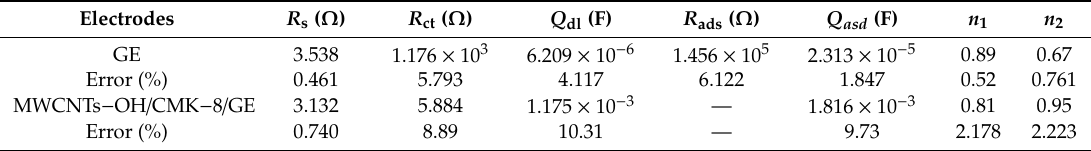
Figure 3. ( A ) Nyquist and ( B ) Bode diagrams of GE and MWCNTs − OH/CMK − 8 modified electrode in 1.0 μ mol/L OLA. T he inset is the Equivalent circuits. Table 1. Equivalent circuit parameters of OLA electro-reduction on di ff erently modified electrodes Table 1. Equivalent circuit parameters of OLA electro-reduction on differently modified electrodes obtained from Figure 3B. obtained from Figure 3B.